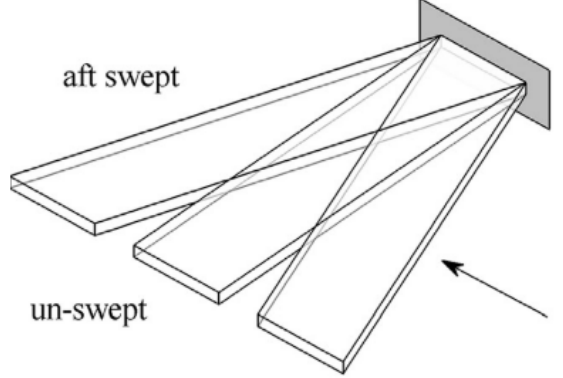
Figure 4. Same thickness plate, Adapt with permission from [47].